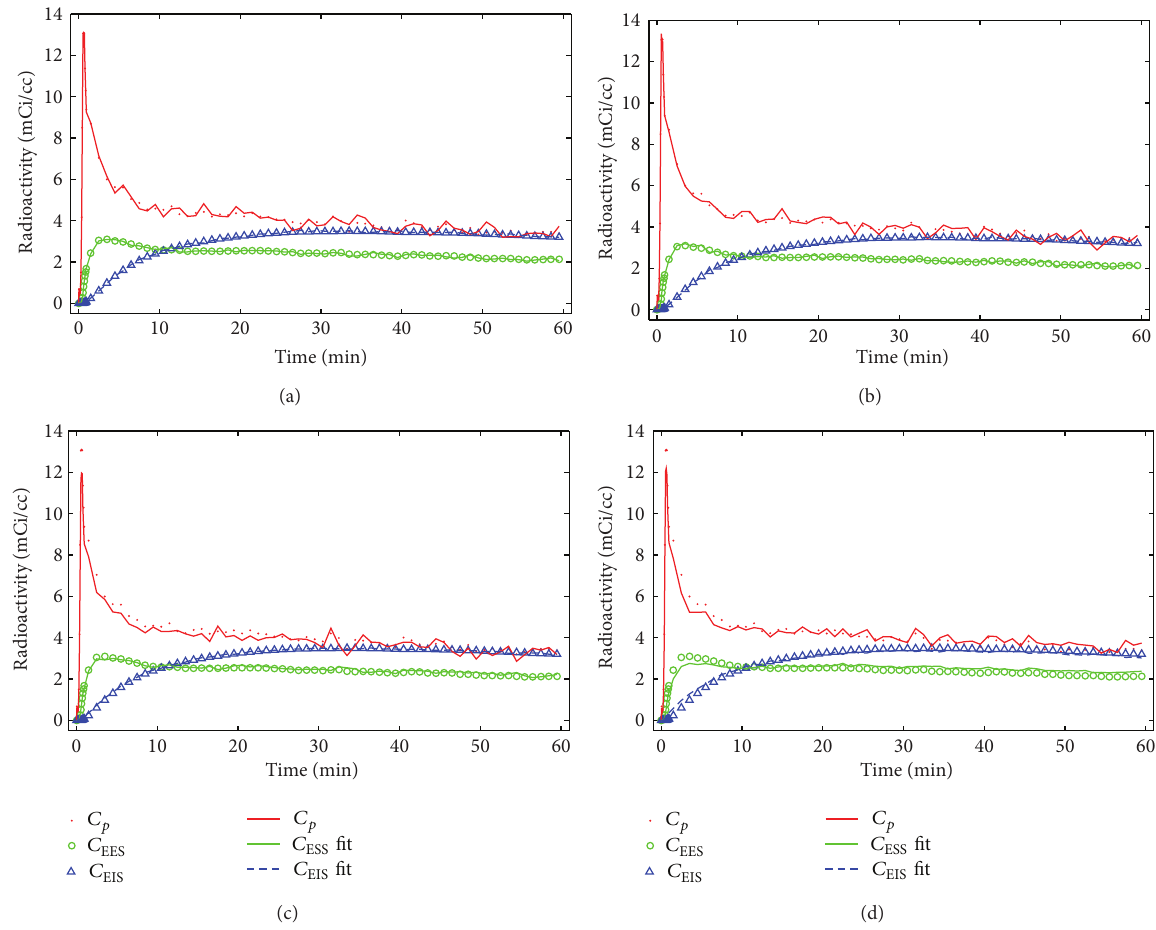
Figure 2: An example of simulated tissue curves and the fits provided by (11). These panels represent 25 voxels with (a) no error in the DCE- MRI parameters, (b) 5% error, (c) 10% error, and (d) 15% error. The AIF used in these simulations was measured from the left ventricle of a mouse, which results in some noise even with no error in the DCE-MRI parameters (see panel